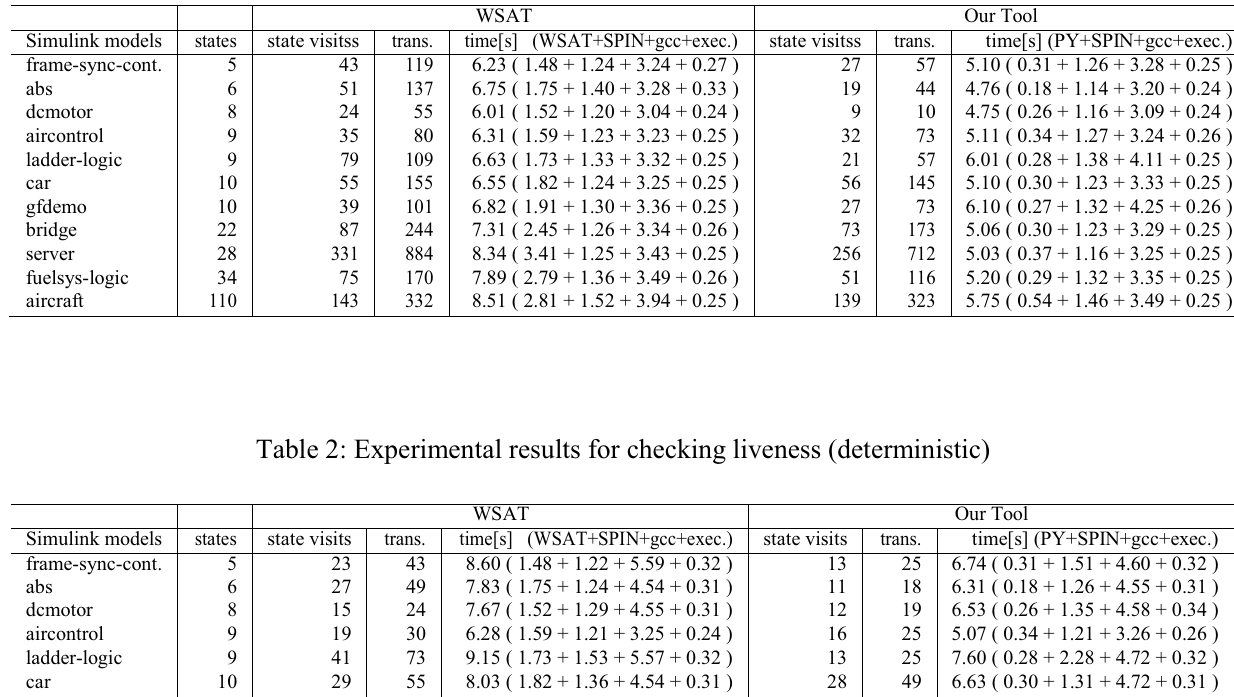
Table 1: Experimental results for checking reachability (deterministic) Simulink models